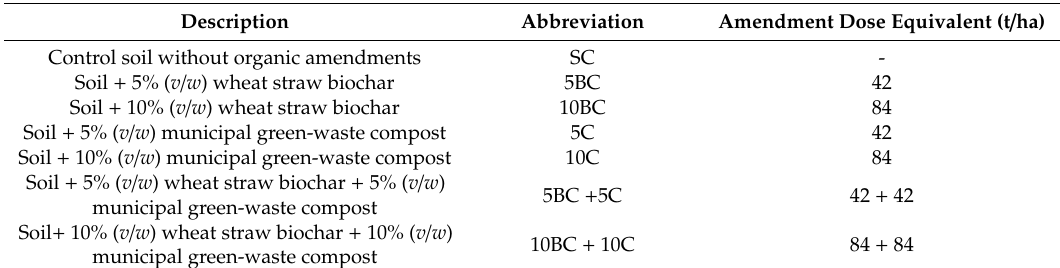
Table 3. Summary of the treatments in greenhouse